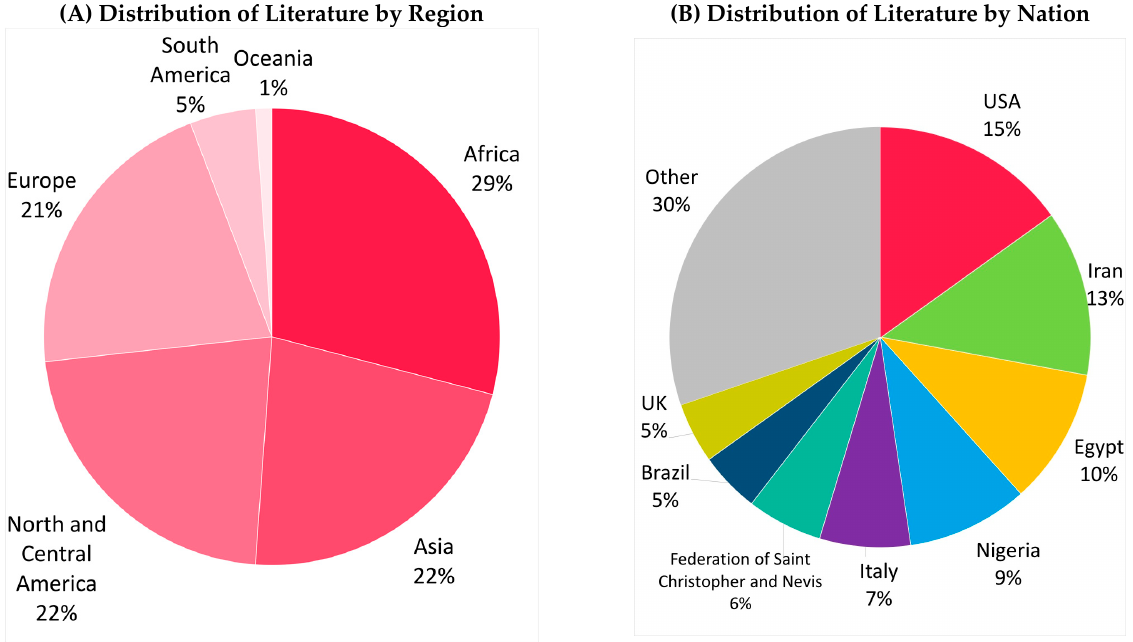
Figure 3. Distribution of the selected literature by region (( A ), n = 86) and nation (( B ), n = 86). “Other” includes Ethiopia (n = 2), Germany (n = 2), India (n = 2), Iraq (n = 2), Kenya (n = 2), Sudan (n = 2), Australia (n = 1), Austria (n = 1), Belgium (n = 1), Canada (n = 1), China (n = 1), the Czech Republic (n = 1), Jordan (n = 1), Mali (n = 1), Pakistan (n = 1), Portugal (n = 1), Saudi Arabia (n = 1), South Africa (n = 1), Spain (n = 1), and Switzerland (n = 1). One record was excluded because a country was not